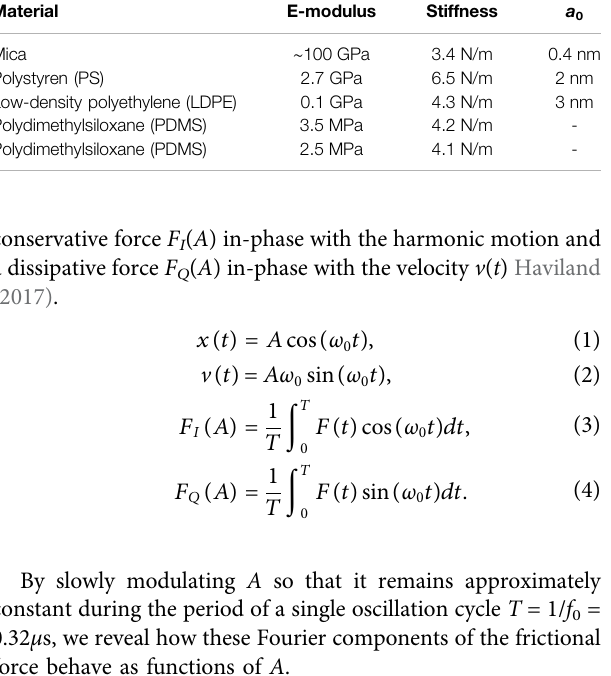
Frontiers in Mechanical Engineering |